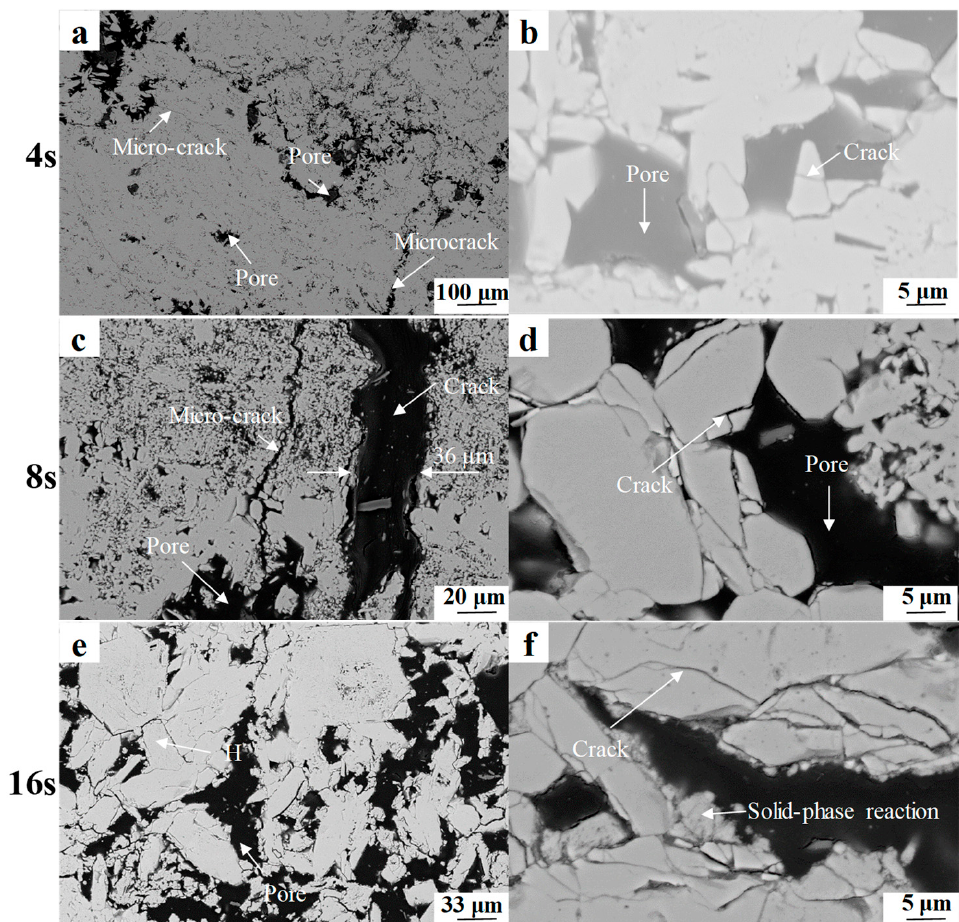
Figure 7. Internal cracking microstructure during the smelting reduction of #2 iron ore. ( a ) Microstructure of cracks at 4 s with 100 μ m scale; ( b ) Microstructure of cracks at 4 s with 5 μ m scale; ( c ) Microstructure of cracks at 8 s with 20 μ m scale; ( d ) Microstructure of cracks at 8 s with 5 μ m scale; ( e ) Microstructure of cracks at 16 s with 33 μ m scale; ( f ) Microstructure of cracks at 16 s with 5 μ m scale.